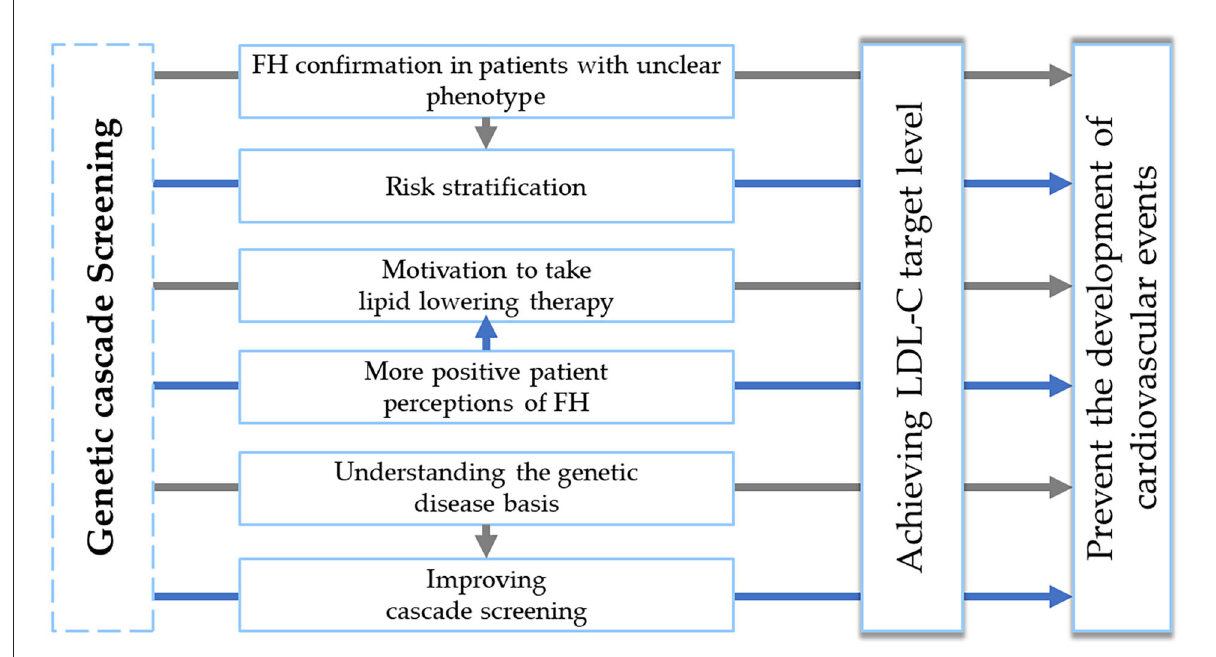
FIGURE3 Genetic cascade screening benefits. FH, familial hypercholesterolemia. LDL-C, low-density lipoprotein